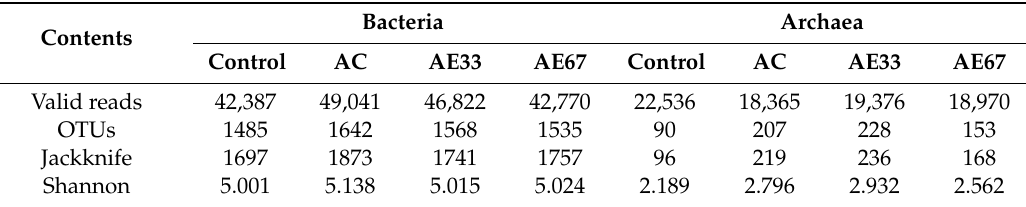
Table 4. Operational taxonomic units (OTUs) and diversity indices for microbial species in the anaerobic reactors.